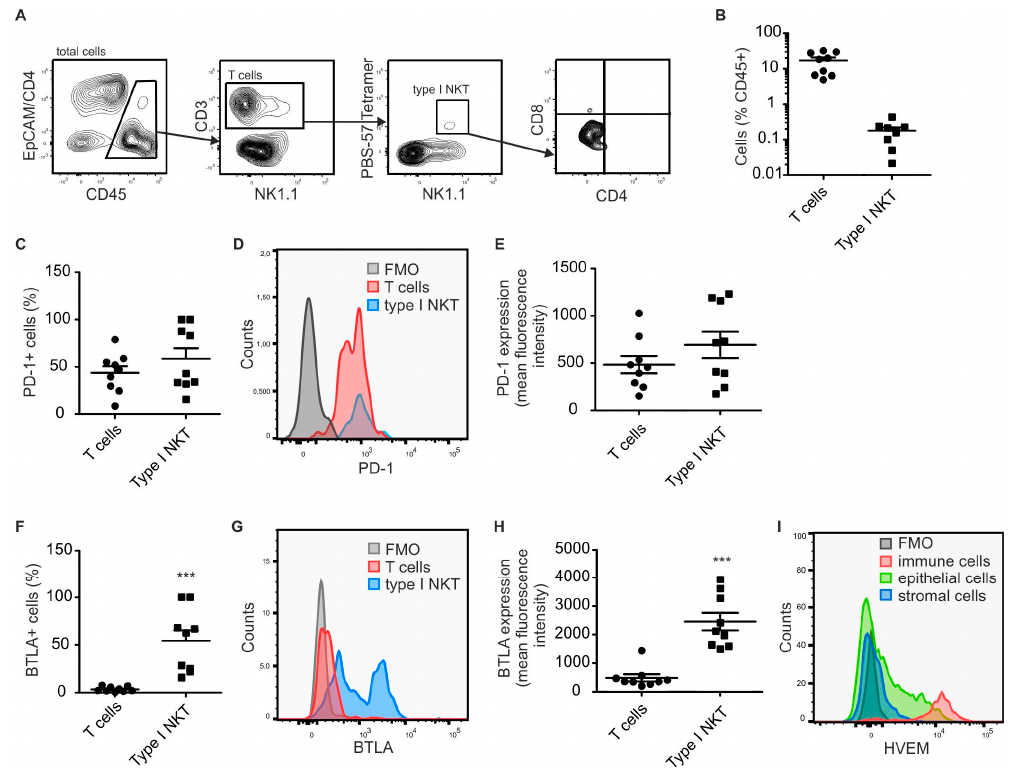
Figure 1. Type I NKT cells express high levels of BTLA in PyMT tumors. PyMT tumors ( n = 9) were